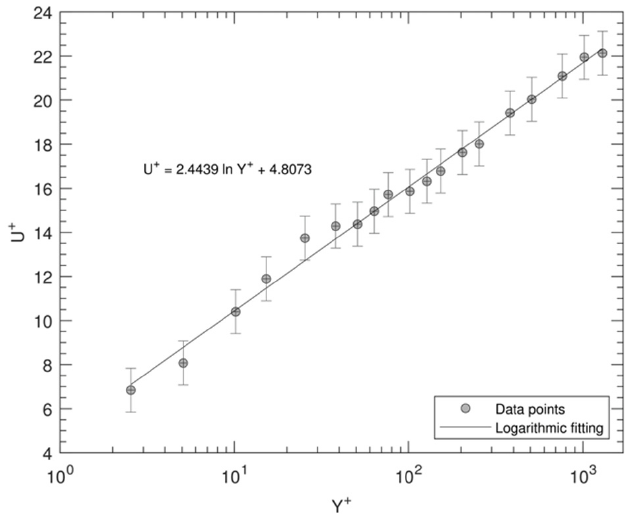
Figure 5. Dimensionless velocity over dimensionless distance from the